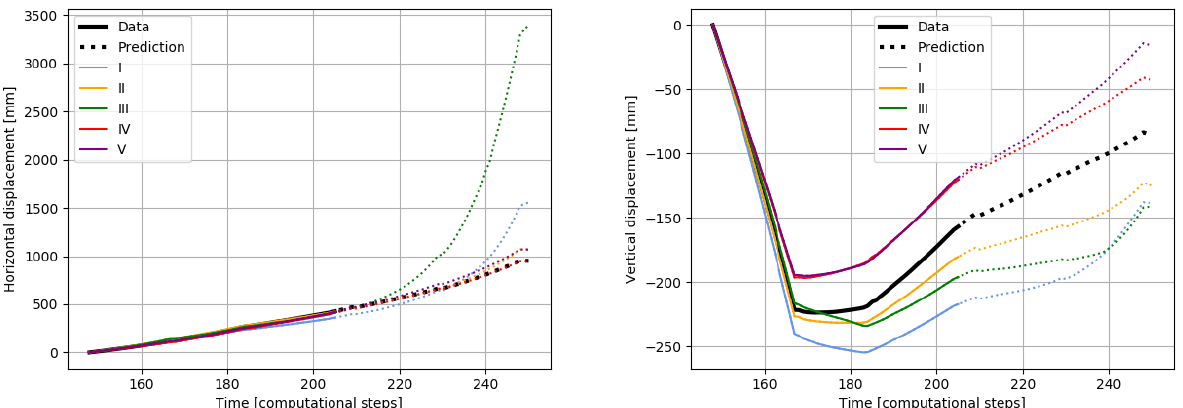
Figure 22: Prediction of horizontal (left) and vertical (right) displacement in benchmark U2.